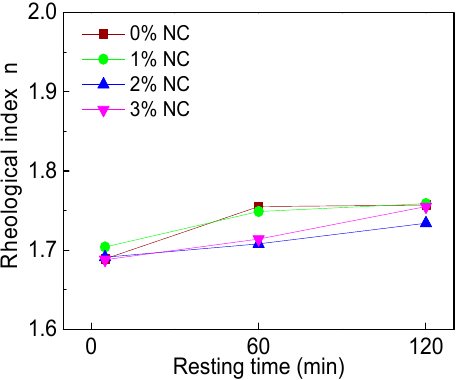
Figure 20. Influence of NC on n.